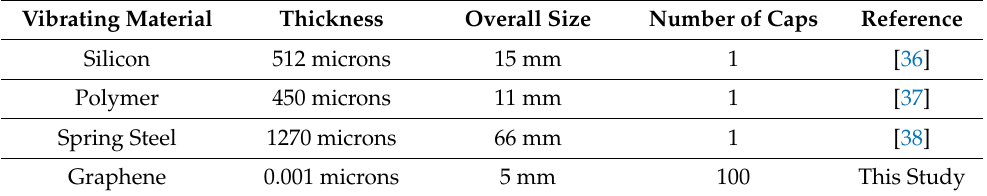
Figure 1. Schematic of graphene energy harvesting circuit using two Schottky diodes, two storage capacitors, a variable capacitor, and a DC bias voltage. The variable capacitor represents the suspended graphene over a fixed metal electrode, as shown in the side illustration. Table 1. Comparisons of key features for variable capacitance device structures.